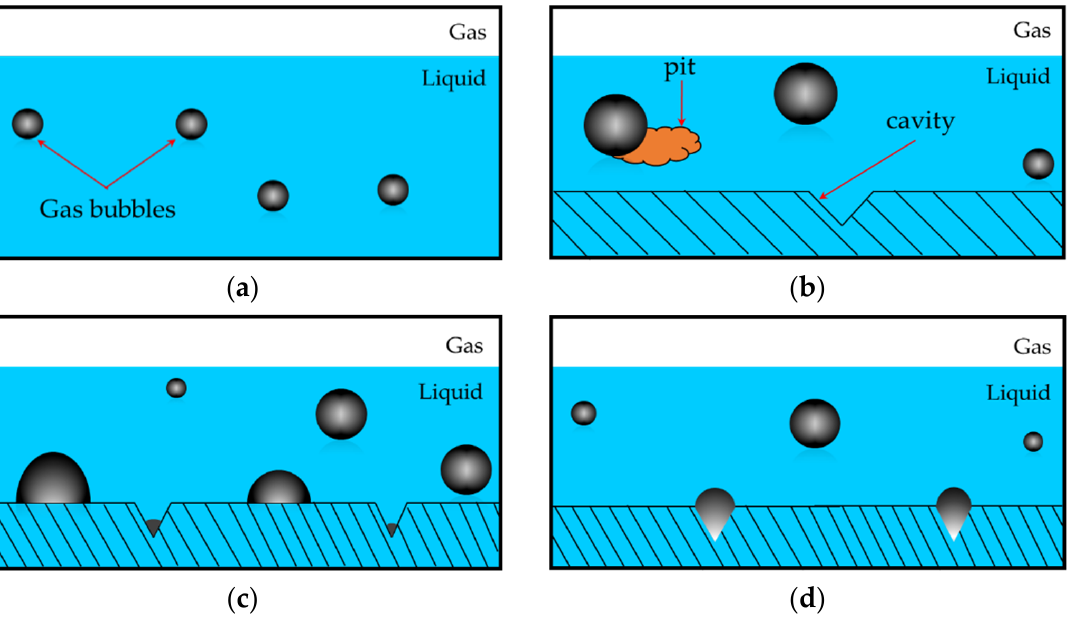
Figure 1. A schematic representation of Type I, Type II, Type III, and Type IV bubble nucleation. ( a ) Type I: Classical homogeneous nucleation; ( b ) Type II: Classical heterogeneous nucleation; ( c ) Type III: Pseudo ‐ classical nucleation; and ( d ) Type IV: Non ‐ classical nucleation.